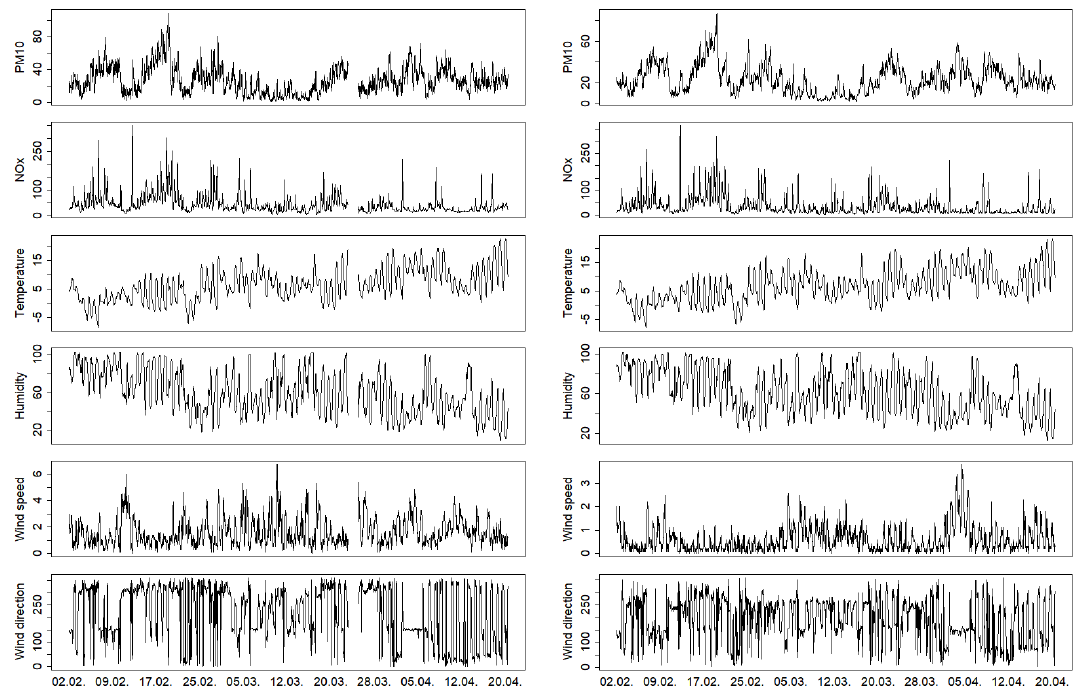
Figure 3. Measured variables: PM 10 ( µ g · m − 3 ), NO x ( µ g · m − 3 ), temperature ( ◦ C), humidity (%), wind speed (m · s − 1 ), and wind direction (degrees); Arboretum station, left; ˇCerná Pole station, right. Table 2. Descriptive statistics of variables (n—the number of observations; Mean—arithmetic mean; Median—median; St. dev.—standard deviation; Min—minimum value; Max—maximum value; Q 0.25 —lower quartile; Q 0.75 —upper quartile; Skewness—skewness,